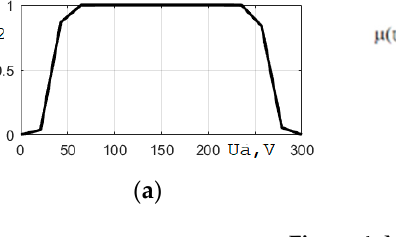
Figure 4. Membership functions of linguistic variable 𝑈 (cid:3028) of the blocks: ( a ) FIS1; ( b ) FIS2; ( c ) FIS3.